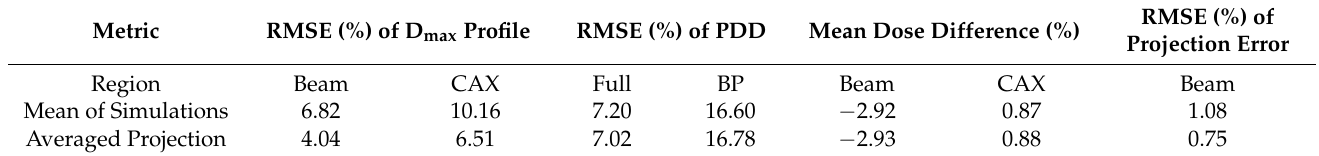
Table 2. Full-noise simulation reconstruction accuracy metrics, comparing the mean of single- simulation results to the averaged projection result. The tomographic reconstruction of DHI-based OC dosimeter dose measurements for a full-noise simulation was performed on the individual simulation projections and the averaged projection. The reconstructed and MC-simulated dose distributions were compared to determine the reconstruction